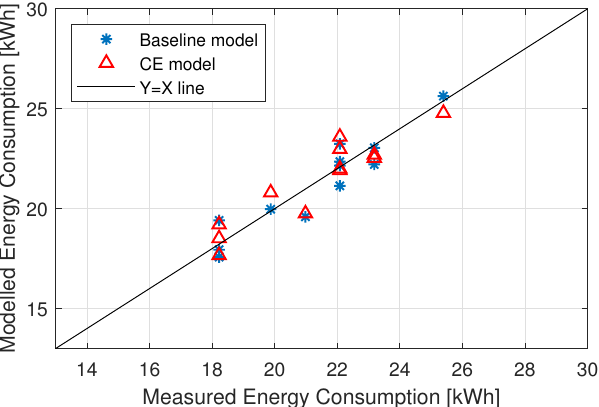
Figure 5. The EB’s modelled and measured electric energy consumption across different drive cycle durations